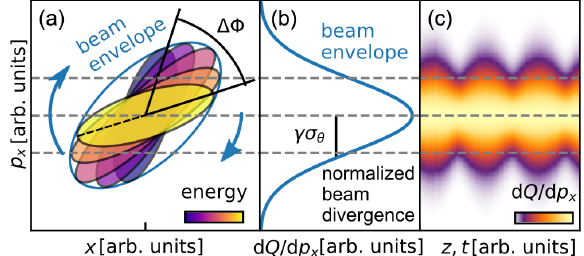
FIG. 1. Beam decoherence: (a) illustrates the transverse phase space of a bunch with finite energy spread consisting of many slices of different electron energy which rotate in phase space with the energy-dependent betatron frequency directed by the focusing force. The beam envelope encircles the sum of all slices, (b) shows the projection d Q= d p x of the beam on p x , which is typically recorded in experiments and used for determining the normalized beam divergence γσ Θ , and (c) shows the time- dependence that is caused by the phase-space rotation of the beam envelope. When the slices in (a) span over Δ ϕ ≥ π , full decoherence is reached and the modulation in (c) vanishes. For Δ ϕ < π , the beam can be extracted at a phase with reduced momentum spread and small σ Θ .